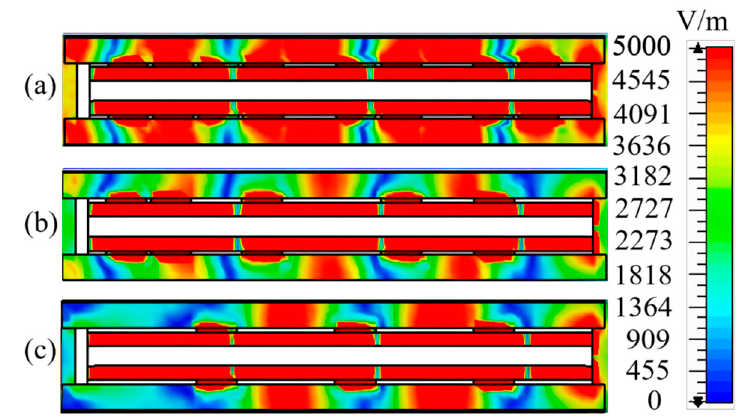
Figure 2. Electric field distributions with different number of slots: ( a ) 8, ( b ) 5, and ( c ) 3.